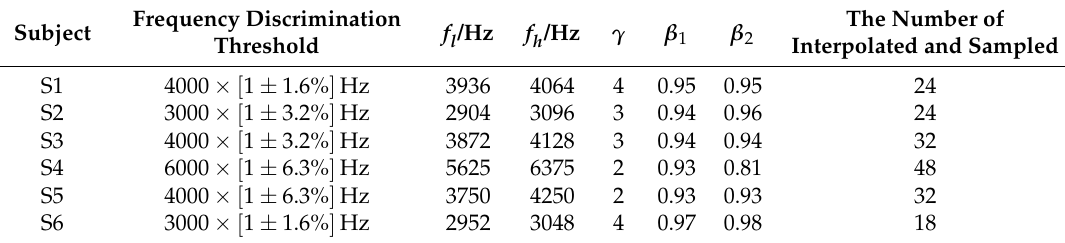
Table 3. The parameters of the piecewise-linear frequency shifting algorithm.